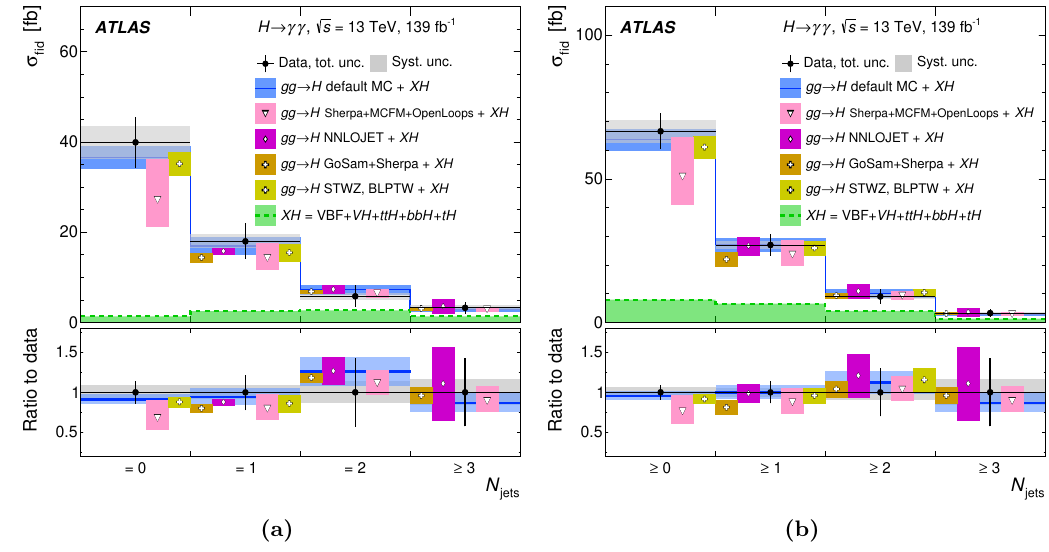
Figure 9. Particle-level fiducial differential cross-sections times branching ratio for (a) the exclusive jet multiplicity N and (b) the inclusive jet multiplicity. The NNLOJET and GoSam+Sherpa jets predictions are available only for the ≥ 1 jet phase space. The STWZ, BLPTW predictions are available only for the exclusive 0, 1-jet bins and the inclusive ≥ 0 , ≥ 1 , ≥ 2 -jet bins.